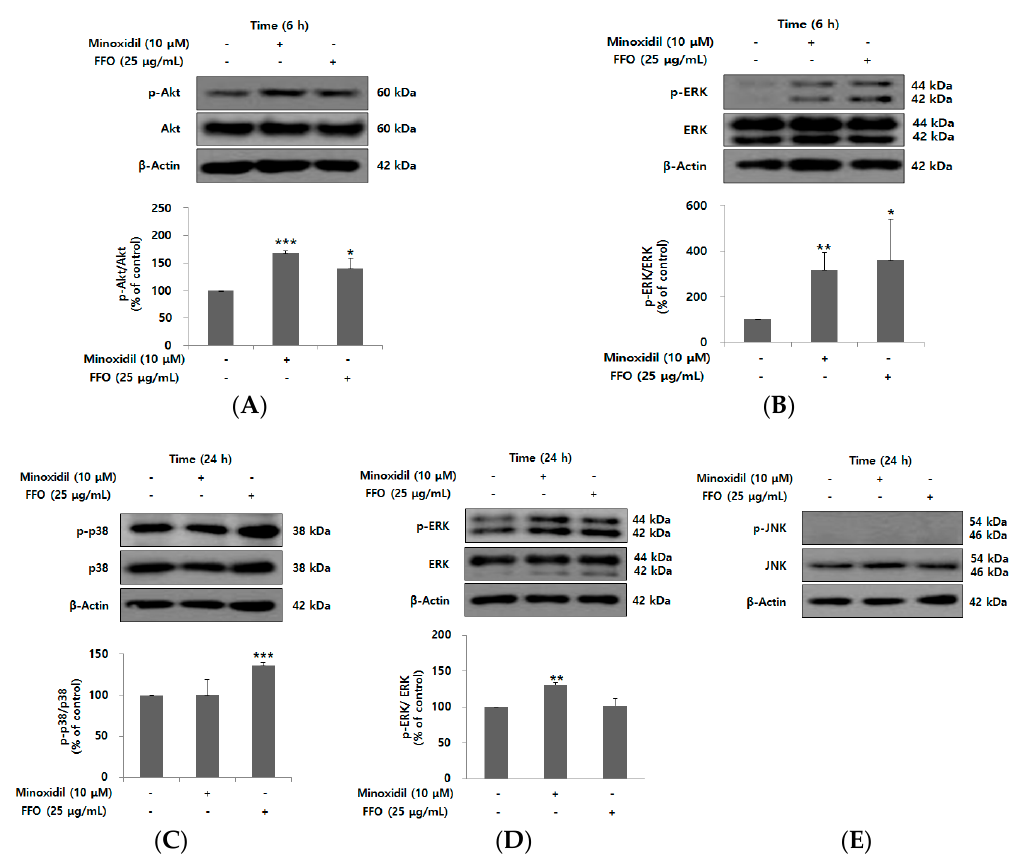
Figure 4. The effect of FFO extract on the level of MAPK and PI3K/Akt signaling proteins. ( A – E ) The DPC were stimulated with minoxidil (10 µ M) or FFO extract (25 µ g/mL) for 6 h or 24 h. Immunoblotting for vehicle, FFO extract and minoxidil-treated DPC lysate shows differential expression of phospho-Akt, phospho-ERK, phospho-p38 and phospho-JNK. β -Actin was used to confirm the same loading of proteins. Graphs represent the quantitative level of the proteins. The data are presented as the mean ± SD from three independent experiments. * p < 0.05, ** p < 0.01, *** p < 0.001 vs. vehicle-treated control.